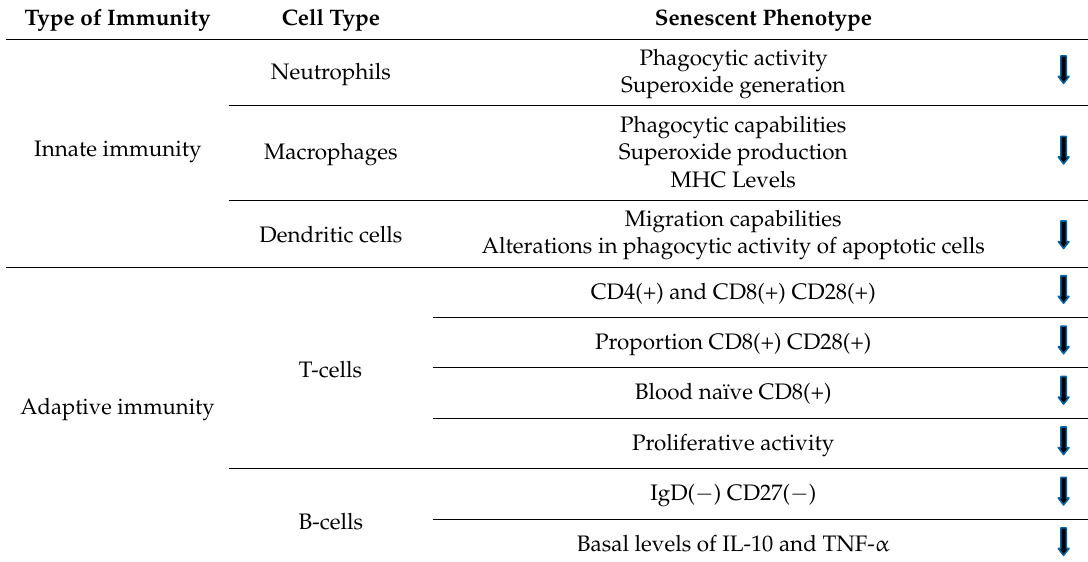
Table 1. Main effect of senescence over immune system.